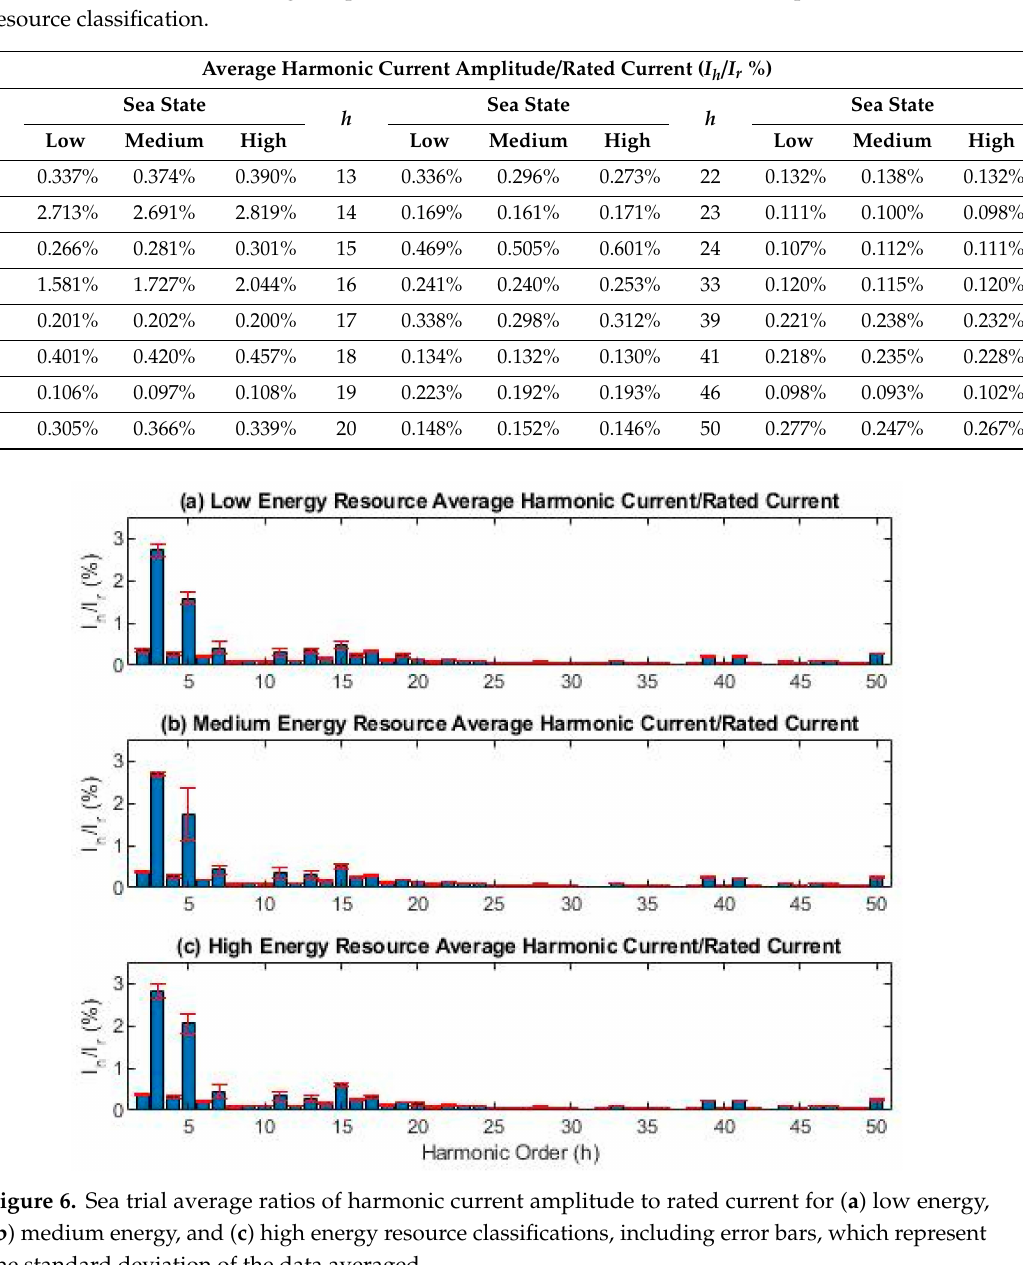
Table 2. Sea trial average reportable ratios of harmonic current amplitudes for each resource classification.